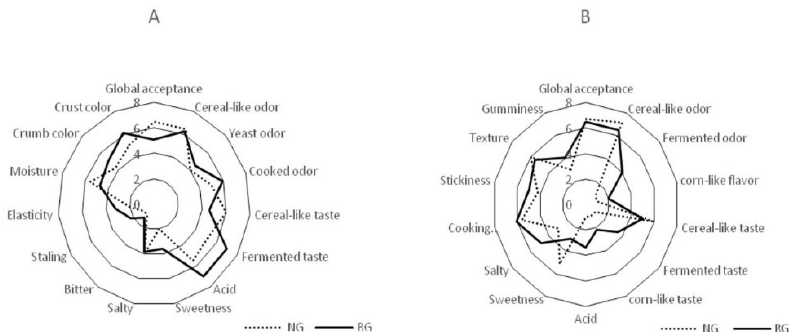
Figure 2. Sensory analysis of bread ( A ) and pasta ( B ) made with normal (NG) or reduced content of gluten (RG) flours. Reduced-gluten wheat flour was fermented with fungal proteases and selected lactobacilli at 30 °C for 8 h. Data are the means of three independent analyses.